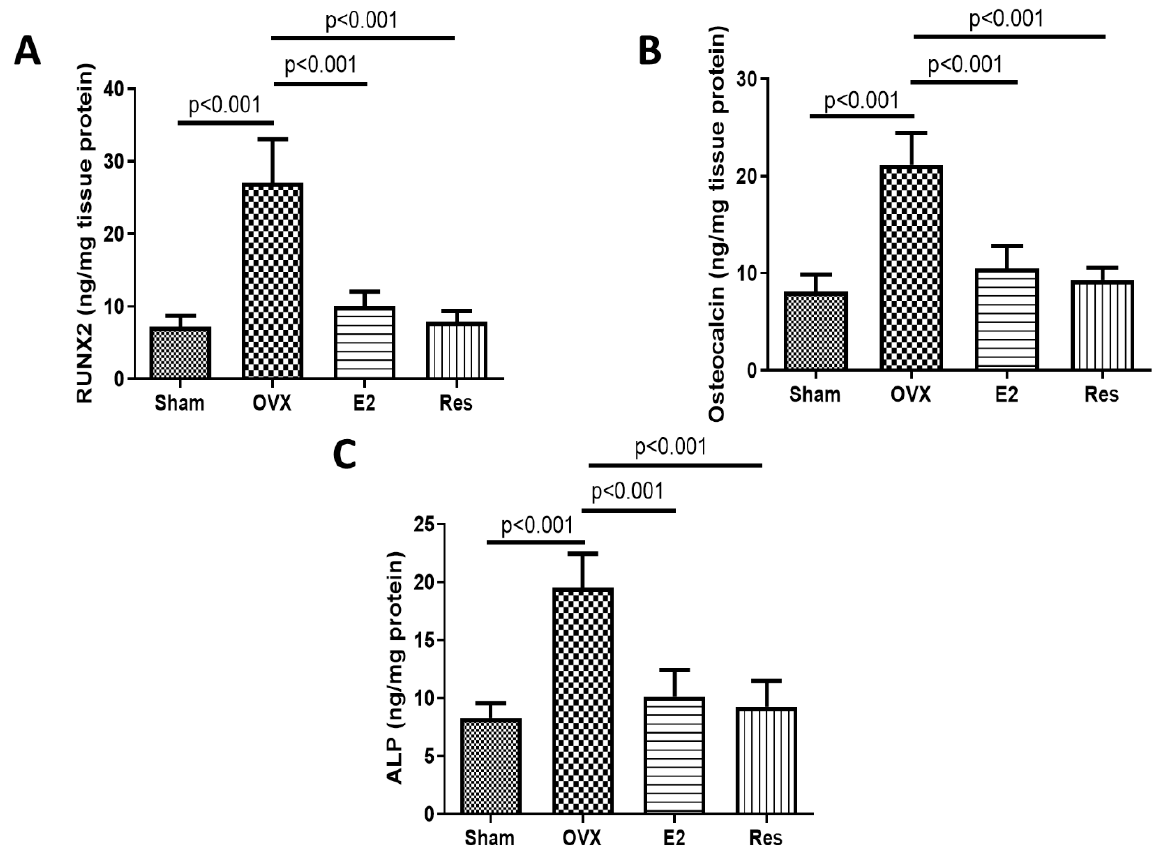
Figure 2. Resveratrol and E2 reduced the aortic levels of osteogenic markers. ( A ) RUNX2 level. ( B ) Osteocalcin level ( C ) ALP level. Protein levels were quantified using ELISA. OVX: ovariectomized rats; E2: estradiol; Res: resveratrol. Graphs show mean ± SD, n = 6.